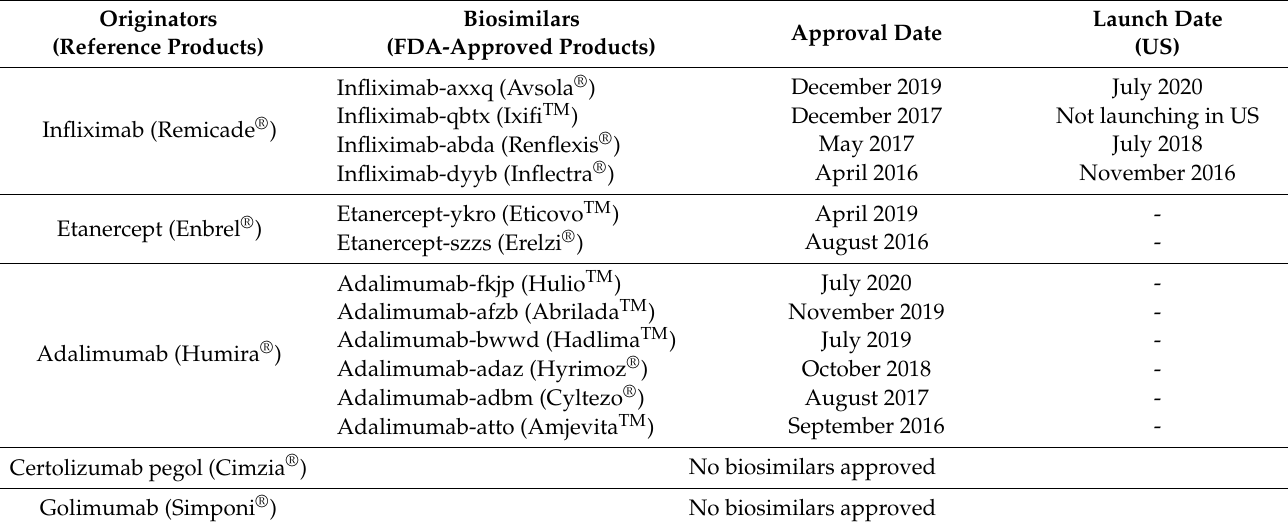
Table 1. TNF- α inhibitor originators and FDA-approved biosimilars by the end of